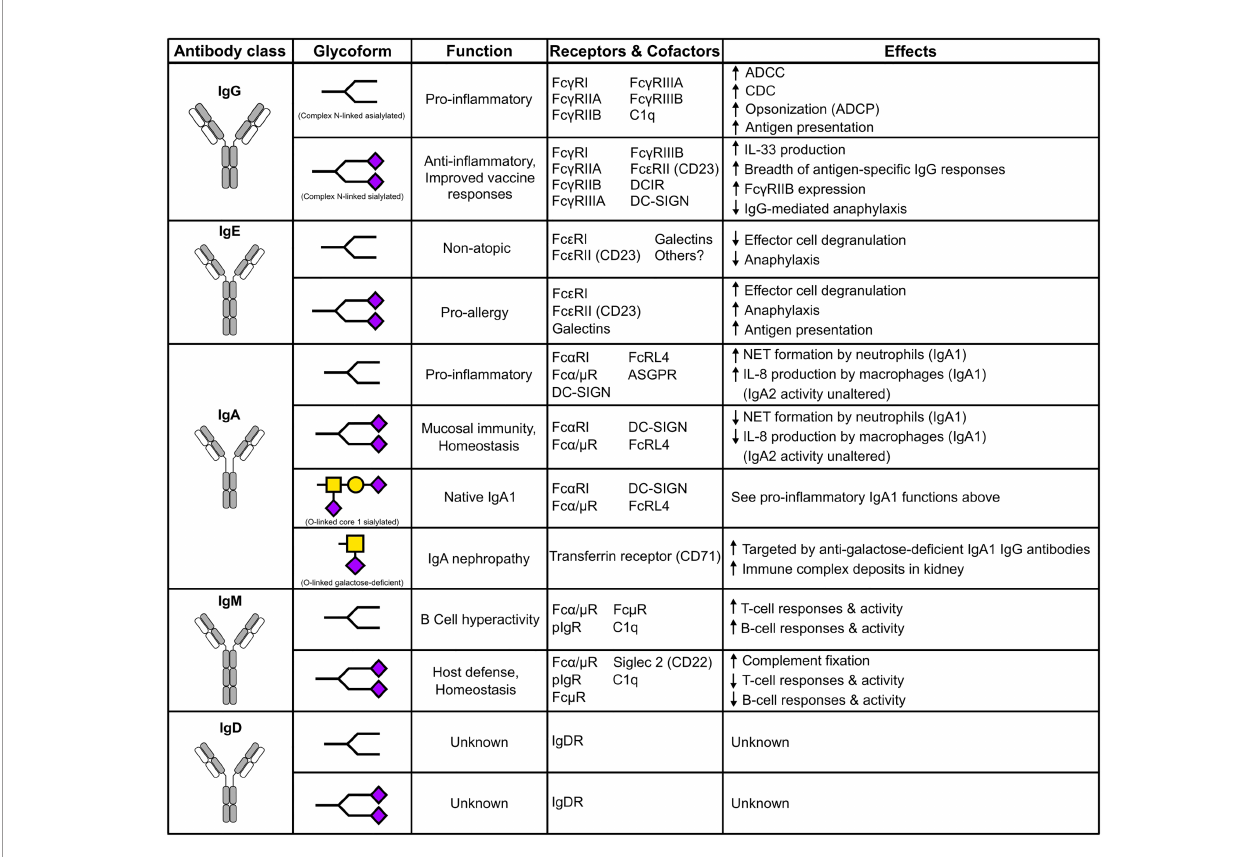
FIGURE 2 | The impact of N- and O-linked sialylation across antibody classes. Antibody schematics are shown, along with skeleton sialylated (terminating in purple diamonds) or asialylated N-linked glycans. O-glycans and IgA1 are comprised of GalNAc (Yellow squares), galactose (yellow circles), and sialic acid (purple